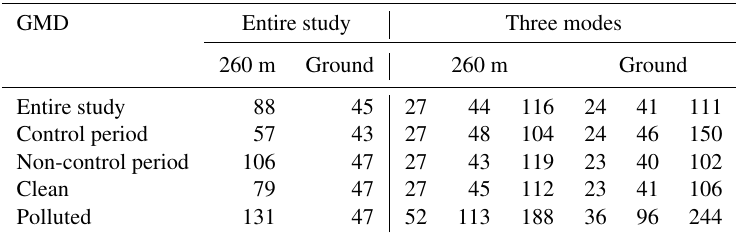
Table 1. The geometric mean diameter (GMD) of average particle number size distribution for different periods at ground level and 260m. Also shown are GMDs of three modes from log-normal fitting. GMD Entire study Three modes 260 m Ground 260